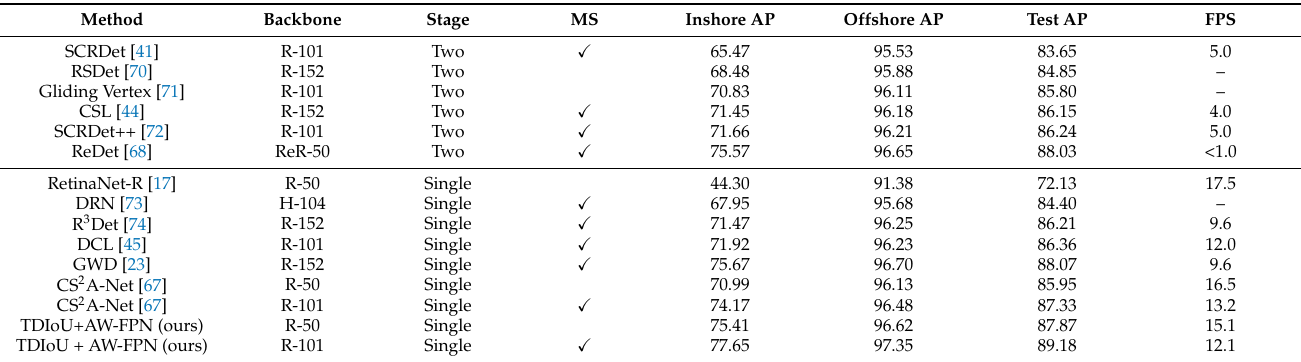
Table 10. Comparison with state-of-the-art methods on RSSD. Here, MS indicates the multi-scale training and testing, FPS is obtained by calculating the overall inference time and the number of images, TDIoU + AW-FPN represents the CS 2 A-Net detector based on TDIoU loss and AW-FPN, R-50 refers to ResNet50 (likewise R-101, R-152), and ReR-50 and H-104 denote ReResNet50 [68] and Hourglass104, respectively